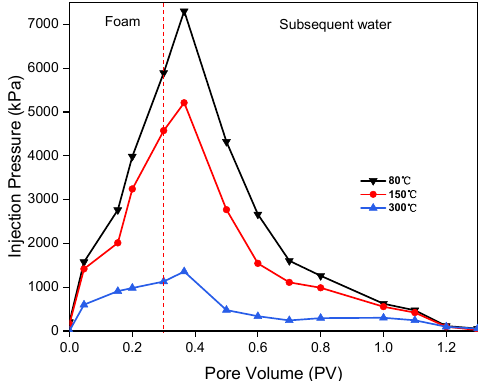
Figure 5. Influence of temperature on injection pressure.